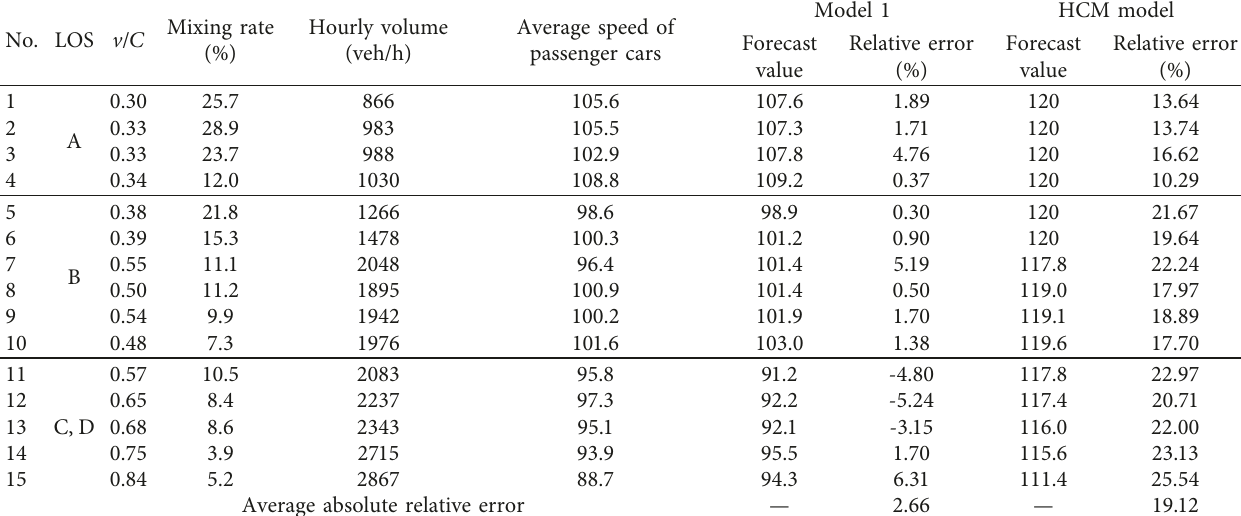
Table 5: : Model prediction of the average speed of passenger cars in